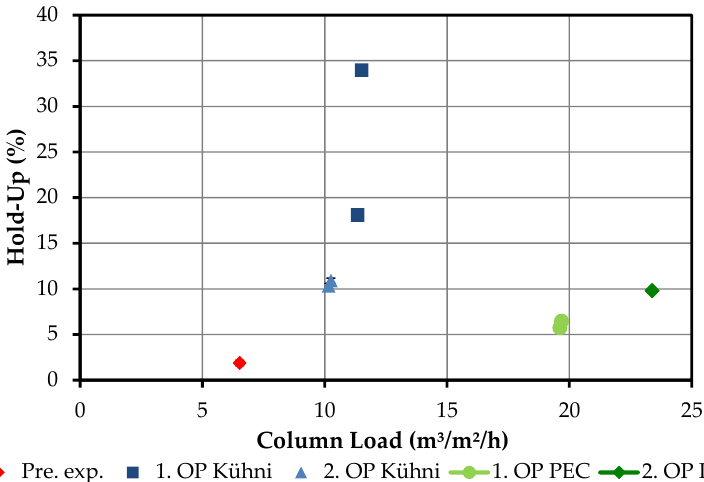
Figure 12. Overview of investigated hold-ups in Kühni and packed extraction columns. OP (operating point), Pre. Exp. (preliminary experiment), PEC (packed extraction column).